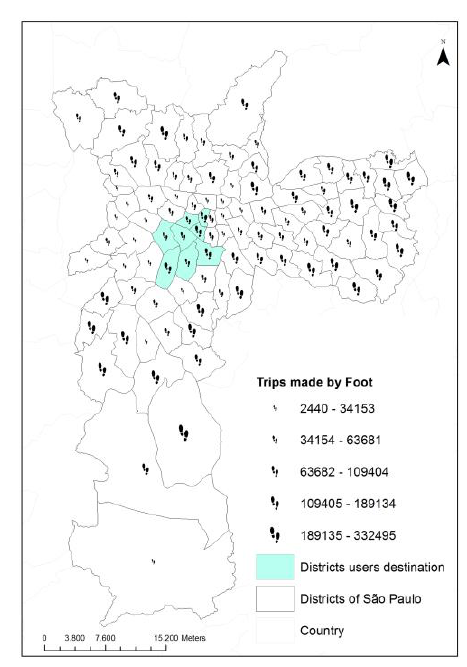
Figure 9. Number of trips: by foot (Source: Authors) As described in the previous section, were considered three analysis scenarios: the first one prioritizing the data of the transportation system (accessibility), the second one prioritizing the flow of people (number of generated trips), and last one prioritizing the land use data (trip origins/destinations). Figures 10 to 12 show the evaluation of the three scenarios. The candidate districts to receive the carsharing stations are at the intersection of the three scenarios (Figure